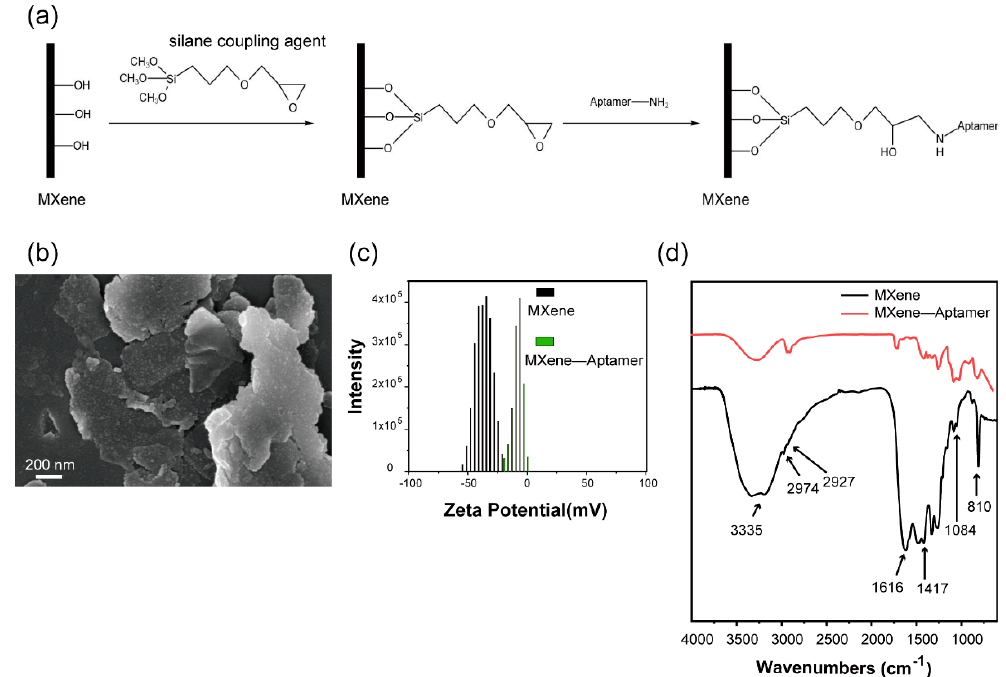
Figure 2. ( a ) Schematics of the preparation of MXene-Aptamer. ( b ) SEM image of MXene-Aptamer. ( c ) Zeta potential of MXene and MXene-Aptamer. ( d ) FITR spectra of MXene and MXene-Aptamer. MXene and MXene-Aptamer. ( d ) FITR spectra of MXene and MXene-Aptamer.